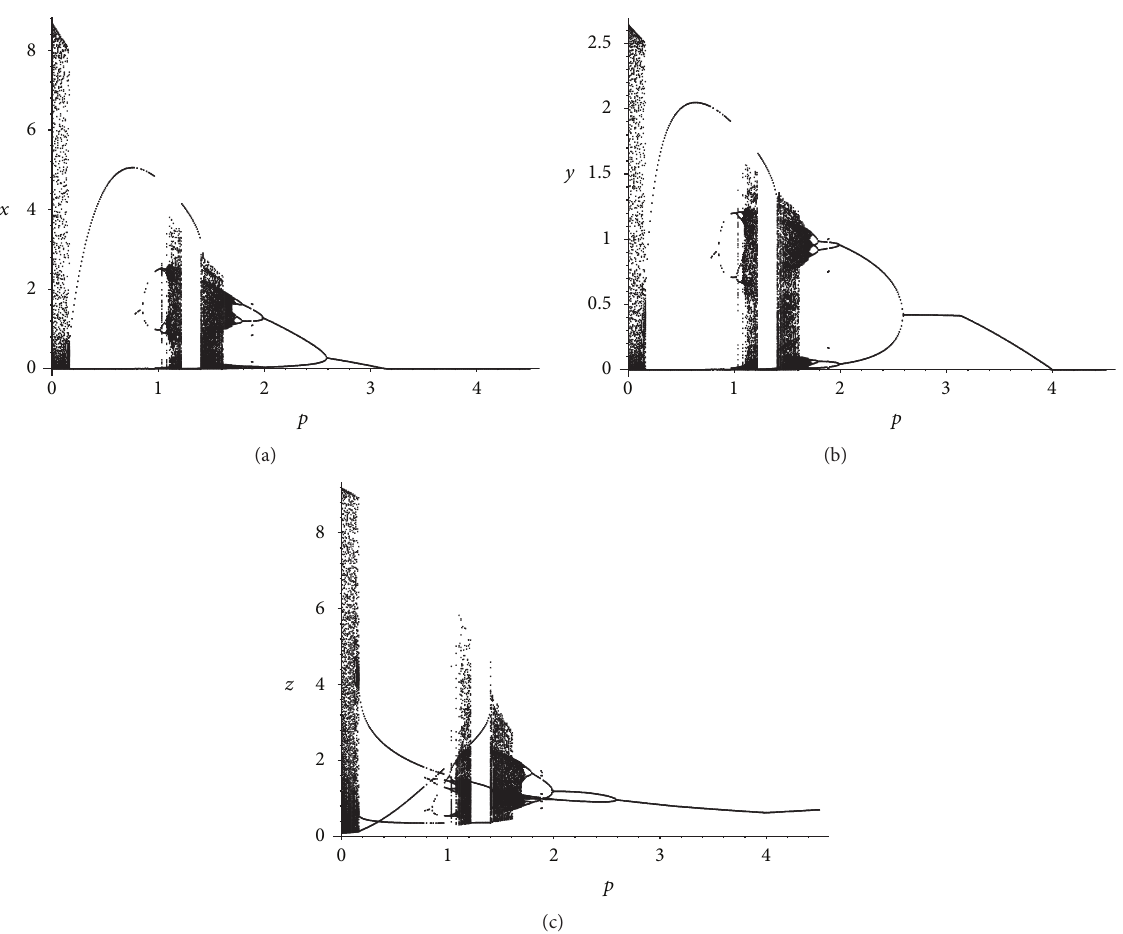
Figure 2: Bifurcation diagram of System (2) with initial conditions 𝑥(0) = 0.3 , 𝑦(0) = 0.5 , 𝑧(0) = 0.3 , 𝑢 = 0.8 , and 0.009 ≤ 𝑝 ≤ 4.5